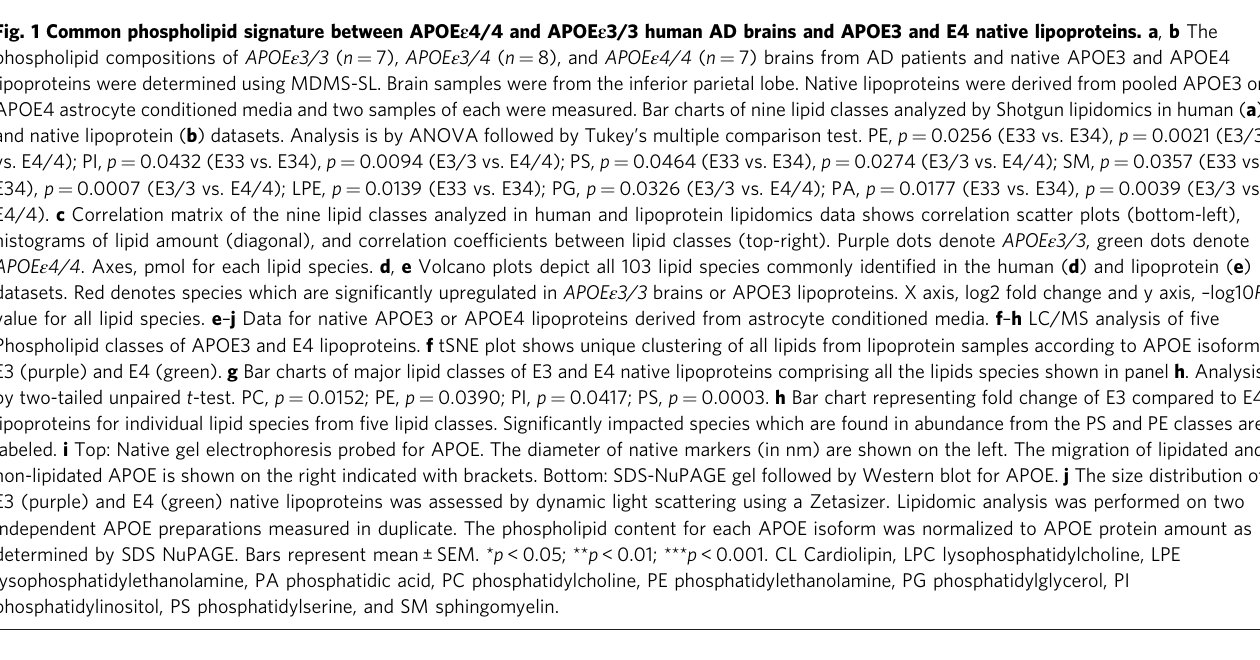
Fig. 1 Common phospholipid signature between APOE ε 4/4 and APOE ε 3/3 human AD brains and APOE3 and E4 native lipoproteins. a , b The phospholipid compositions of APOE ε 3/3 ( n = 7), APOE ε 3/4 ( n = 8), and APOE ε 4/4 ( n = 7) brains from AD patients and native APOE3 and APOE4 lipoproteins were determined using MDMS-SL. Brain samples were from the inferior parietal lobe. Native lipoproteins were derived from pooled APOE3 or APOE4 astrocyte conditioned media and two samples of each were measured. Bar charts of nine lipid classes analyzed by Shotgun lipidomics in human ( a ) and native lipoprotein ( b ) datasets. Analysis is by ANOVA followed by Tukey ’ s multiple comparison test. PE, p = 0.0256 (E33 vs. E34), p = 0.0021 (E3/3 vs. E4/4); PI, p = 0.0432 (E33 vs. E34), p = 0.0094 (E3/3 vs. E4/4); PS, p = 0.0464 (E33 vs. E34), p = 0.0274 (E3/3 vs. E4/4); SM, p = 0.0357 (E33 vs. E34), p = 0.0007 (E3/3 vs. E4/4); LPE, p = 0.0139 (E33 vs. E34); PG, p = 0.0326 (E3/3 vs. E4/4); PA, p = 0.0177 (E33 vs. E34), p = 0.0039 (E3/3 vs. E4/4). c Correlation matrix of the nine lipid classes analyzed in human and lipoprotein lipidomics data shows correlation scatter plots (bottom-left), histograms of lipid amount (diagonal), and correlation coef fi cients between lipid classes (top-right). Purple dots denote APOE ε 3/3 , green dots